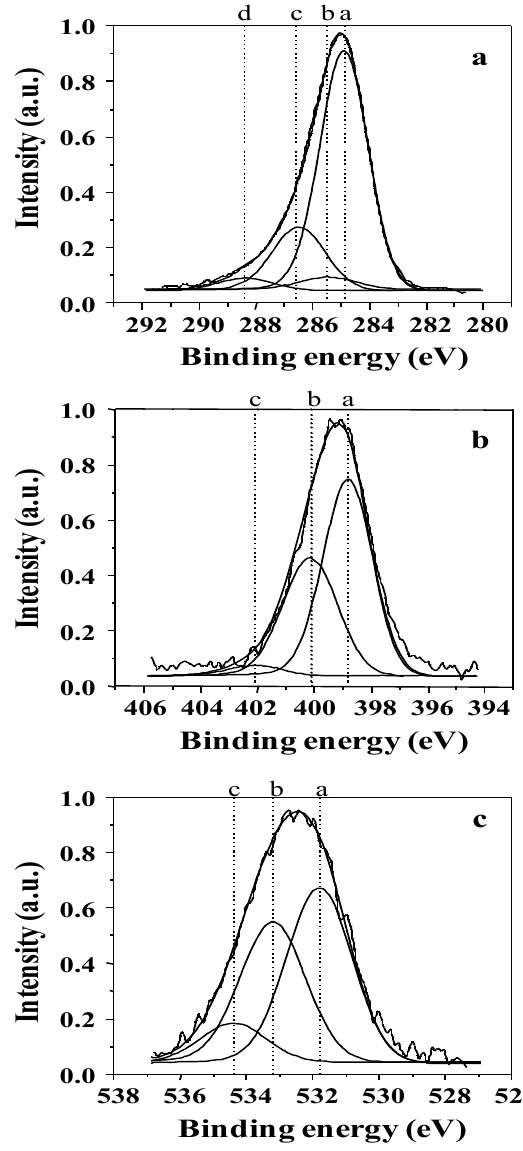
Figure 5. Examples of X-ray photoelectron spectroscopy (XPS) peak decomposition for ( a ) C ; ( b ) N ; and ( c ) O photoelectrons in bulk of non-quaternized films analyzed 1s 1s 1s